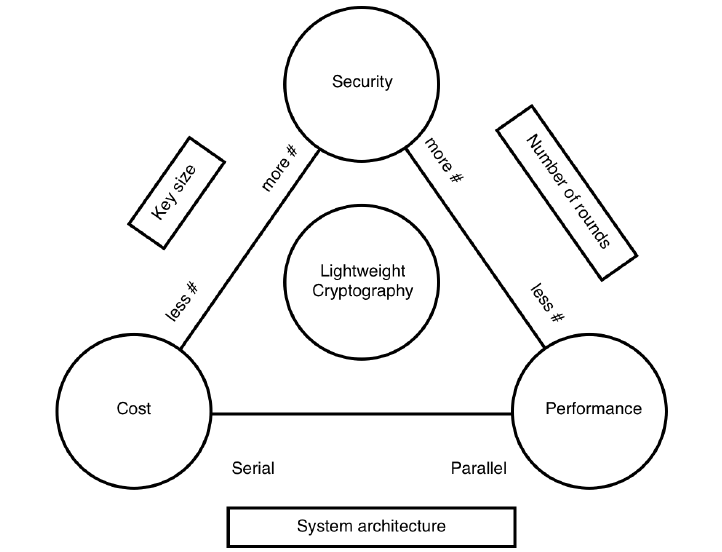
Figure 1. Lightweight cryptography: design